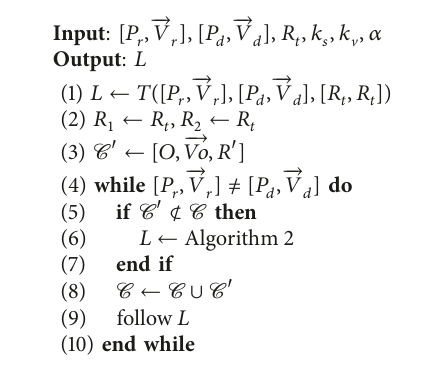
Algorithm 3: DAPF path planning